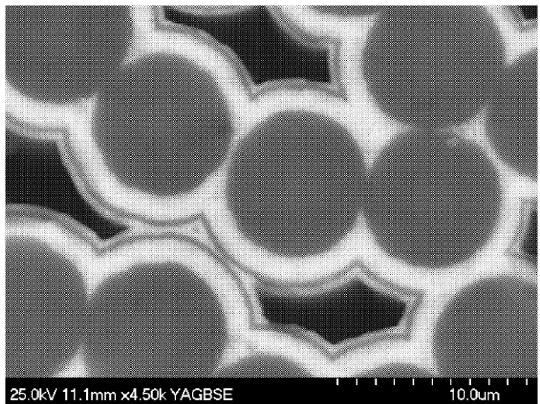
Figure 1. Scanning electron microscopy (SEM) photograph of a carbon fiber-reinforced multi-layered pyrocarbon-silicon carbide matrix (C/C–SiC) composite [23].